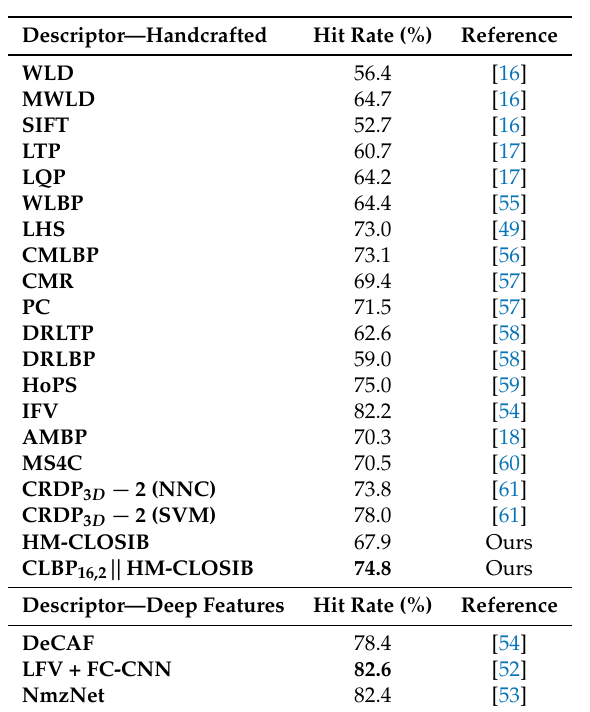
Table 6. Hit rates obtained by the proposed booster, the combination of the booster with CLBP and the reported classification scores for 18 state-of-the-art methods on the KTH-TIPS2-a. Scores are as originally reported. Our proposal is highlighted in bold, together with the best proposal of the Deep Features.